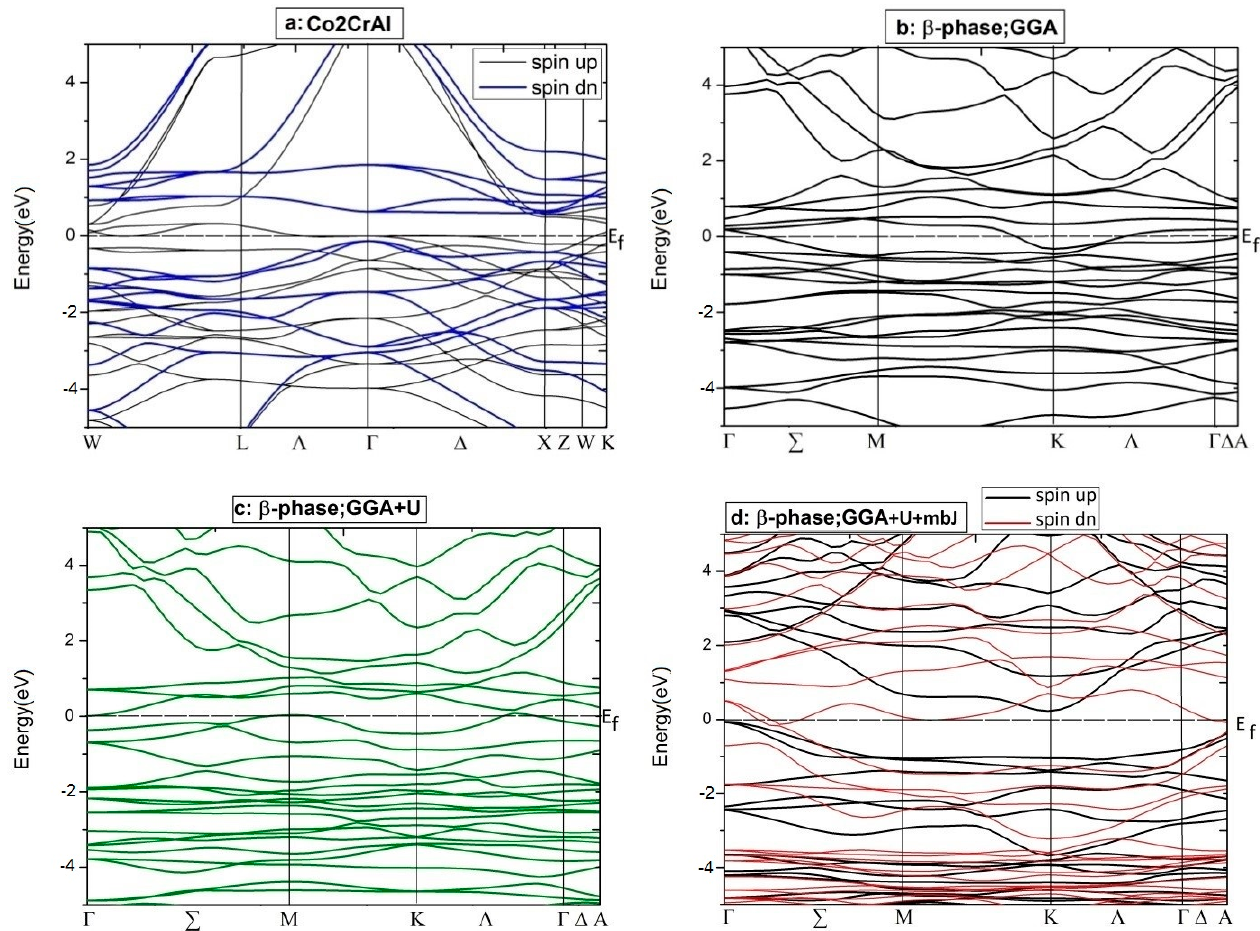
Figure 5. The total DOS of four phases of Co 2 CrAl for three different approximations: ( a ) Bulk phase, ( b ) α phase, ( c ) γ phase, ( d ) β phase by GGA, ( e ) β phase by GGA+U, ( f ) β phase by GGA+U+mBJ, and ( g ) The Partial DOS of β phase by GGA+U+mBJ.